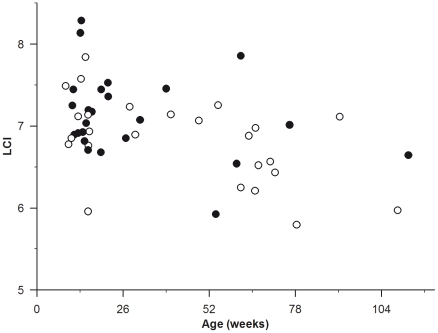
Lung clearance index (LCI) plotted against age (weeks) in infants diagnosed with cystic fibrosis following newborn screening.Infants with air trapping are shown in closed circles.